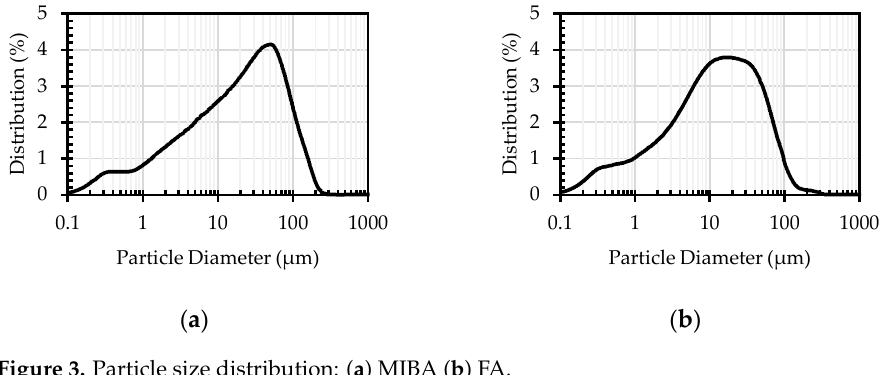
Figure 3. Particle size distribution: ( a ) MIBA ( b ) FA.